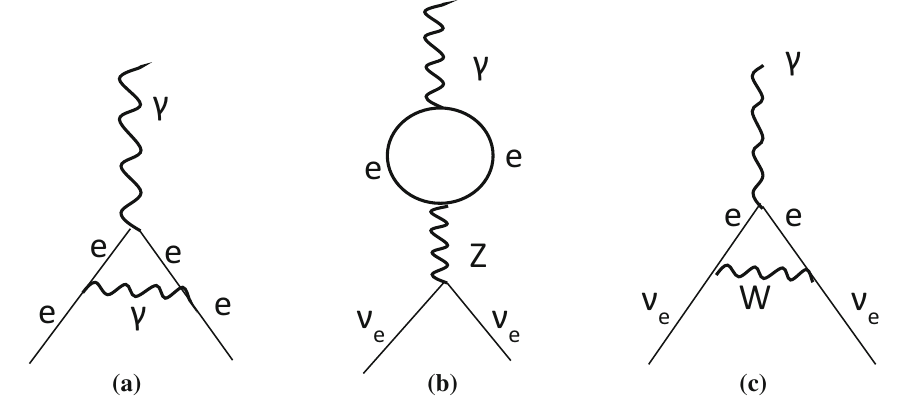
Fig. 1 First order radiative corrections to plasmons in the electroweak model results into a coupling of the photon with electron or neutrino or the interaction of leptons with the magnetic field. Radiative corrections to electromagnetic vertex ( a ), the tadpole diagram ( b ) corresponds to